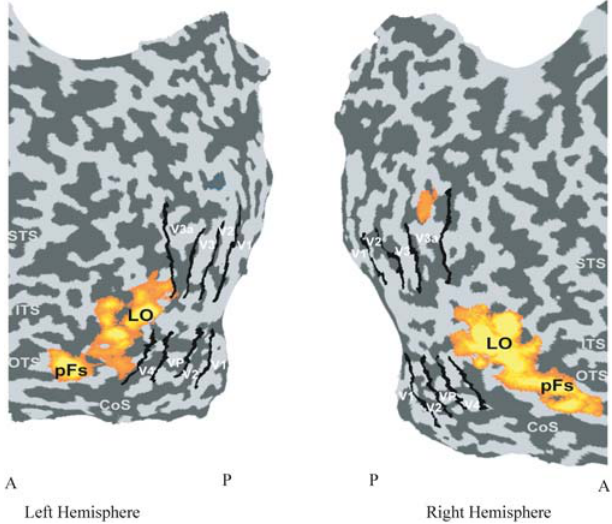
Figure 2. ROIs Functional activation maps for one subject showing the early retinotopic ventral (V1, V2, VP, and V4) and dorsal (V1, V2, V3, and V3a) areas and the LOC subregions. Functional activations (color-maps) are superimposed on flattened cortical surfaces of the right and left hemispheres. A, anterior; CoS, collateral sulcus; ITS, inferior temporal sulcus; OTS, occipitotemporal sulcus; P, posterior; STS, superior temporal sulcus. DOI: